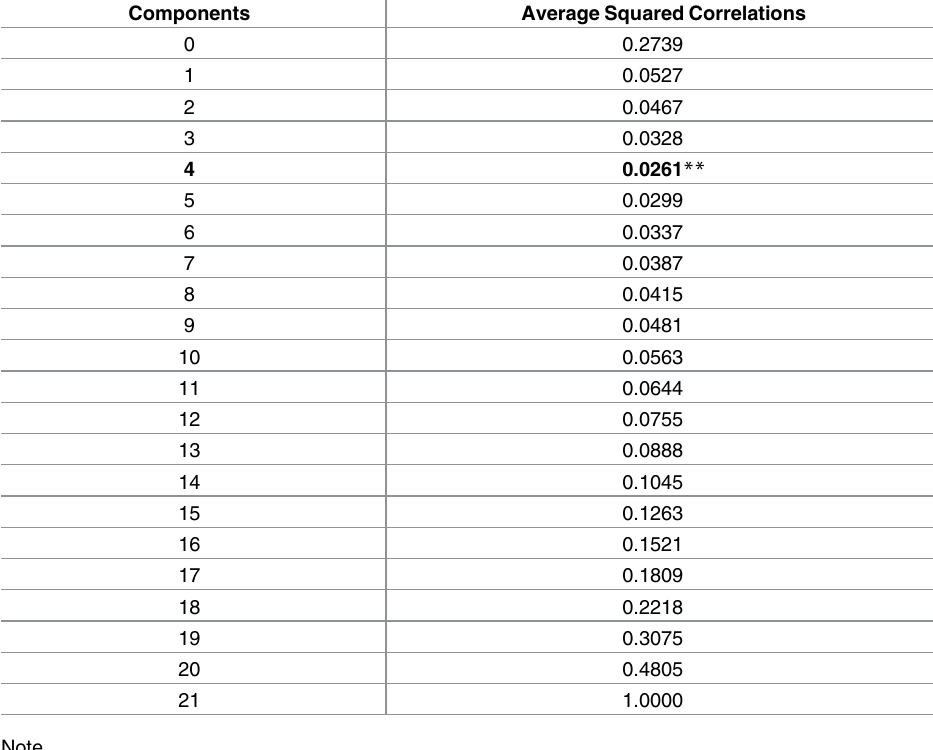
Table 3. Velicer’s averagesquared